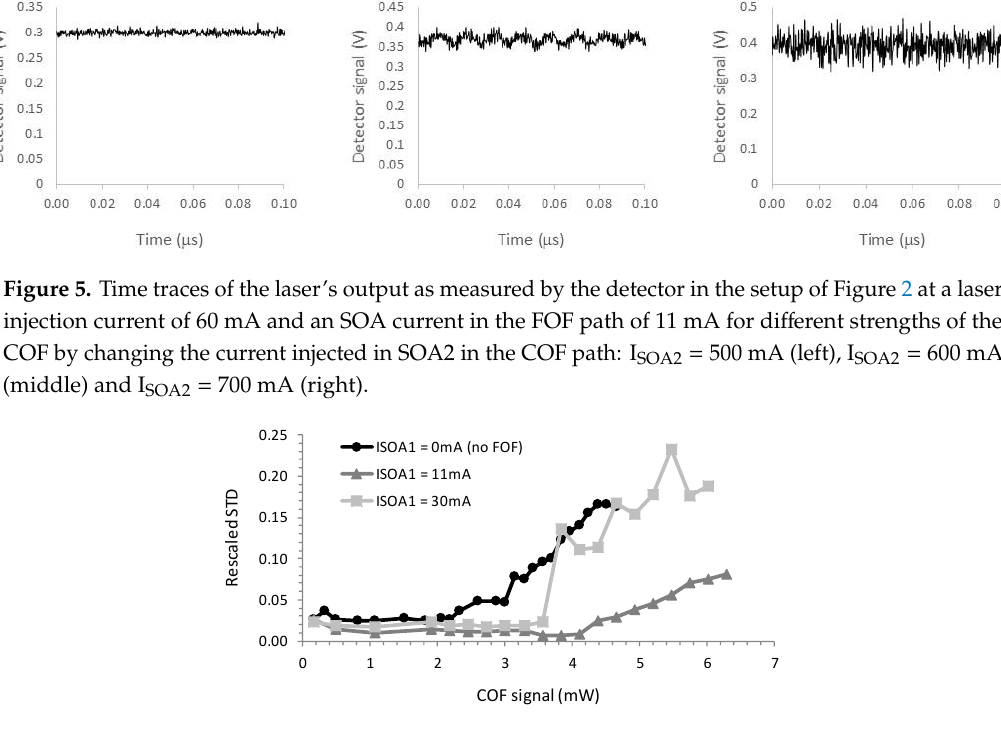
Figure 6. Rescaled STD from time traces of the laser’s output as a function of the COF signal strength as measured after the splitter in Figure 2 for different values of the I SOA1 (which controls the FOF strength).